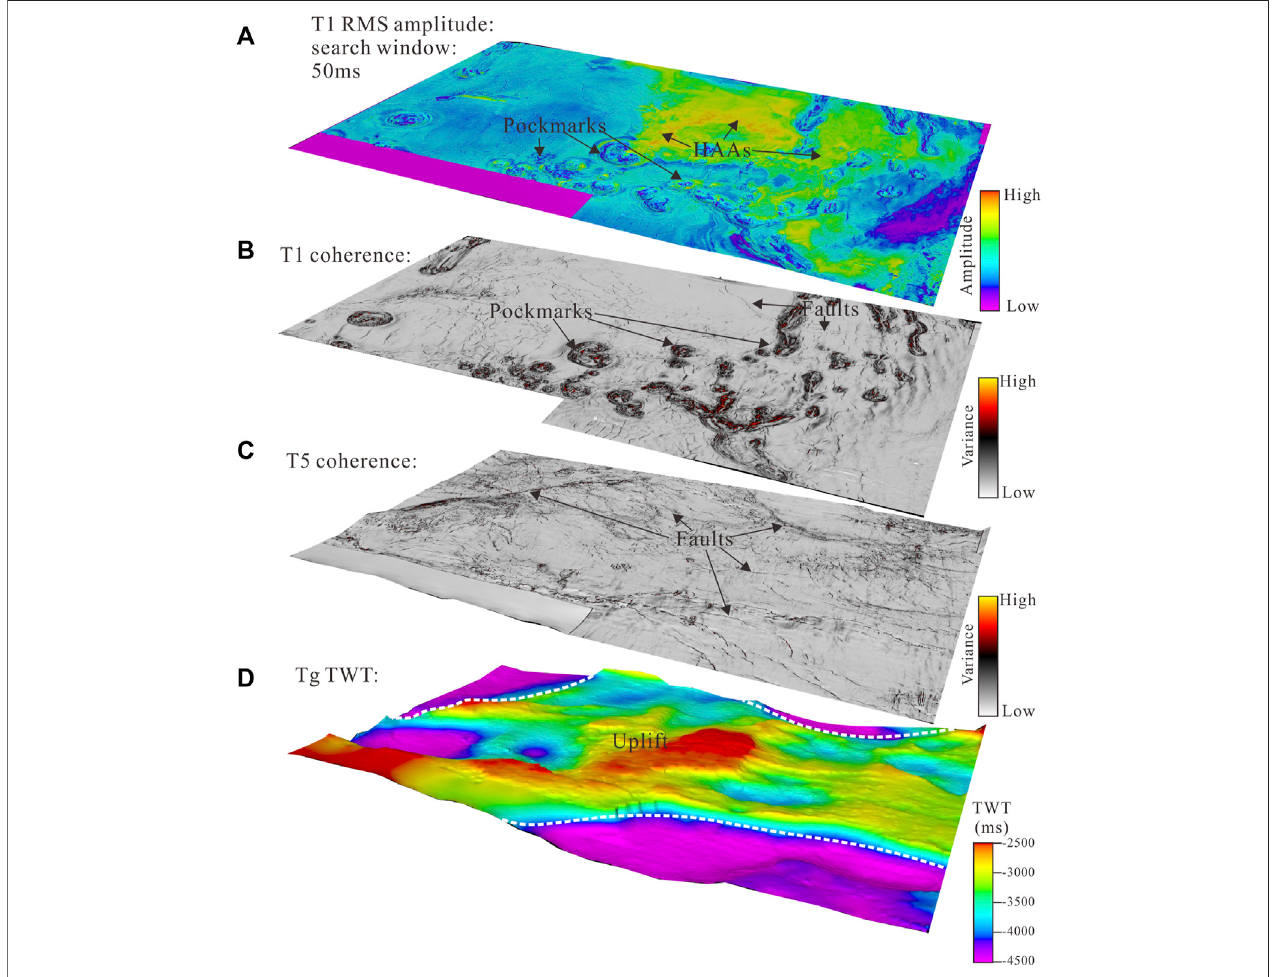
FIGURE 11 | (A) RMS amplitude map extracted from horizon T1 with a time window of 50 ms. (B) Coherence slice extracted along horizon T1 showing the distribution offaults and pockmarks. (C) Coherence slice alongthe horizon T5 showing the distribution of normal faults originated from the basement (D) Theisochronal map of horizon Tg showing the lower